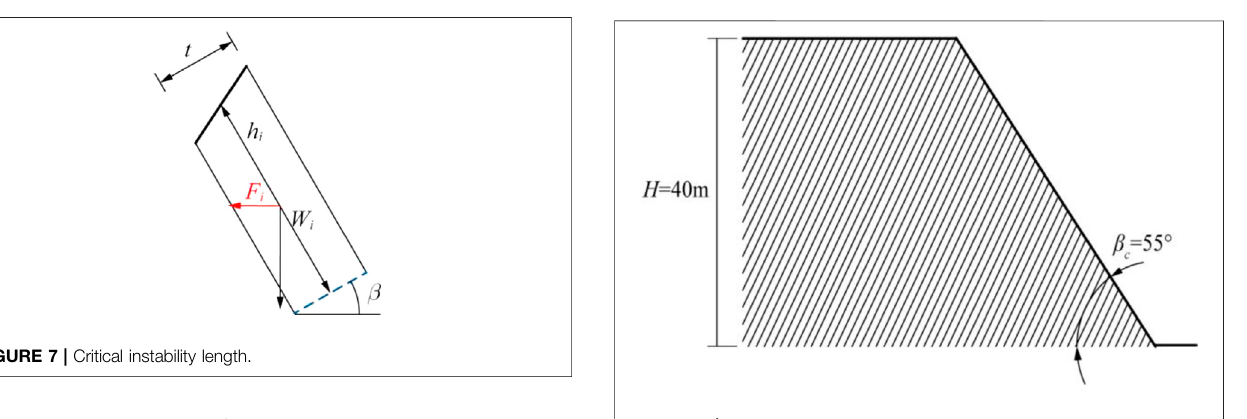
FIGURE 8 | Geometric description of the anti-dip rock slope model in southern